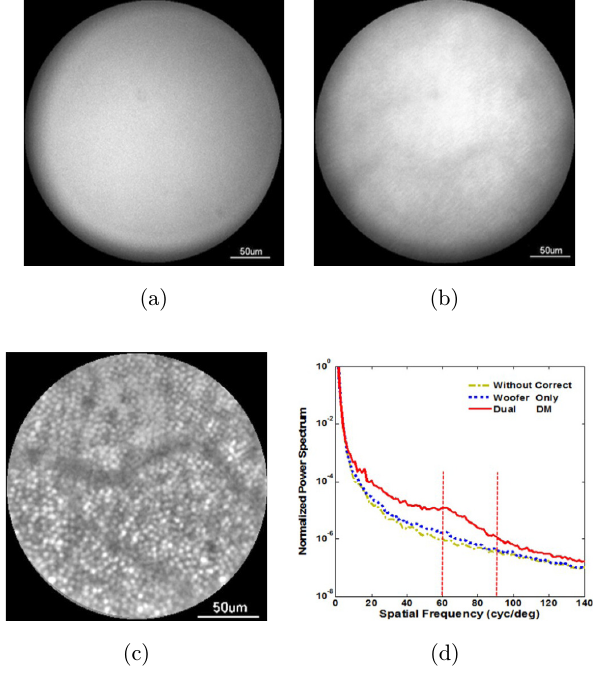
Fig. 9. Retinal imaging results of Subject LB and the nor- malized power spectra of images. (a) – (c) are the retinal images obtained without AO correction, with Bimorph DM corrected and with dual DMs corrected, respectively, the imaging area is at the retinal location of 2 (cid:5) Nasal and 2 (cid:5) Superior and the ¯eld of view is 1 (cid:5) . (d) was the normalized power spectra of images (a) – (c).